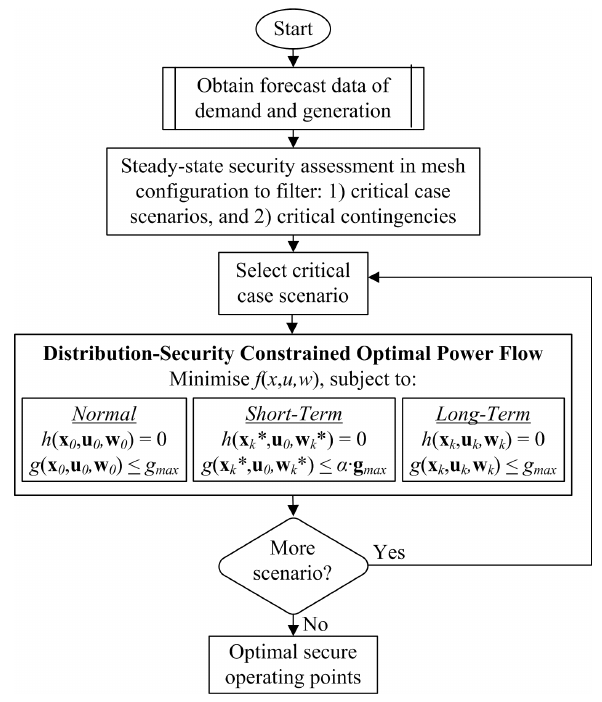
Figure 1. The flowchart of the introduced ANM (active network management)